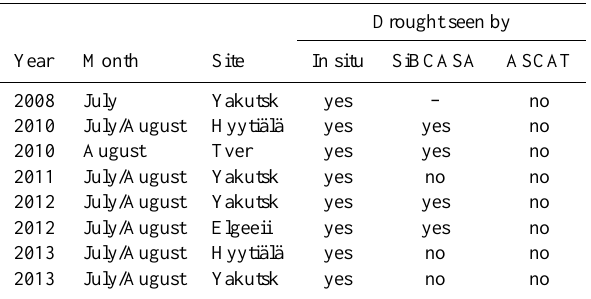
Table 2. Detection of in situ observed drought occurrences by SiB- CASA and